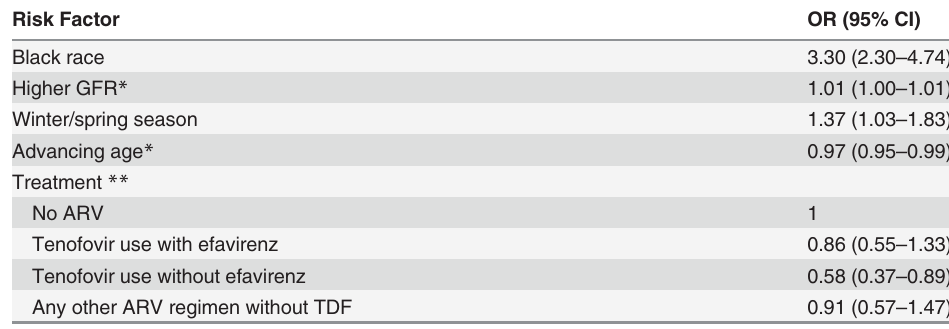
Table 5. Risk factors associated with Vitamin D deficiency, HIV-positive patients; multivariate